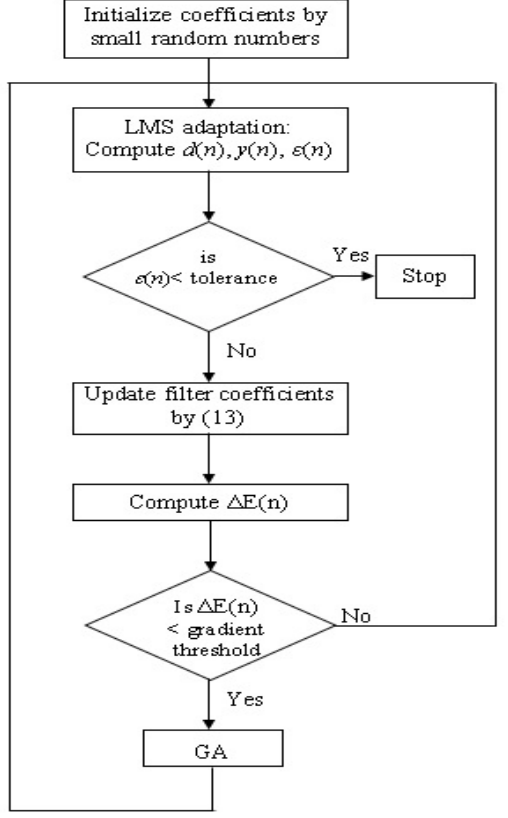
Figure 12. Flowchart of the new learning algorithm (LMS-GA).